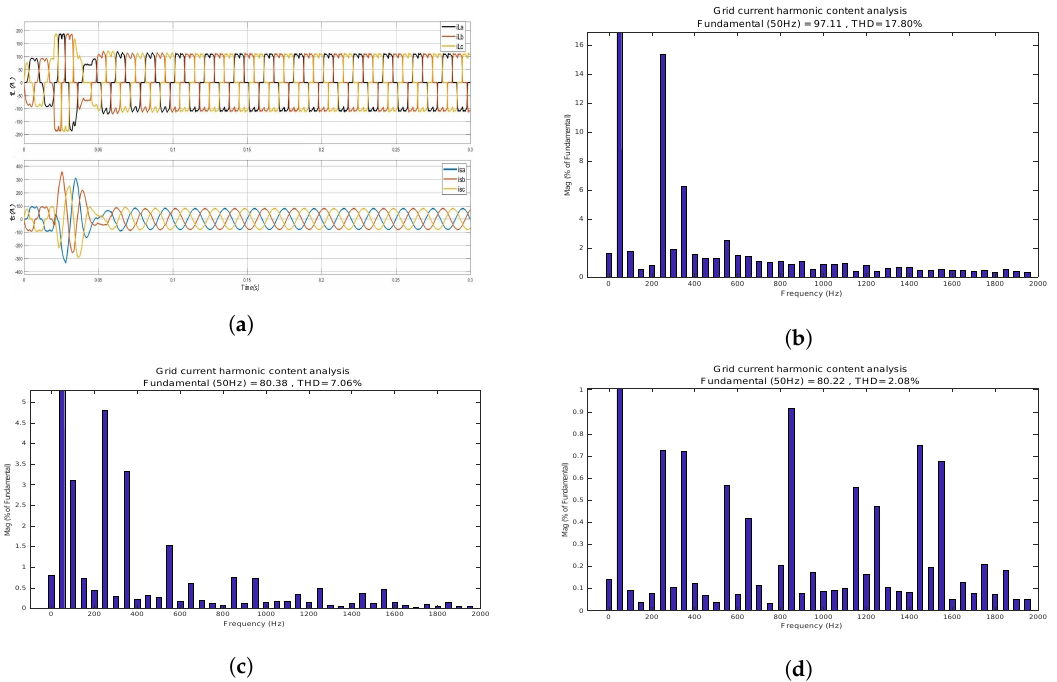
Figure 9. Scheme I: ( a ) nonlinear load current and grid current; ( b ) the FFT result of the nonlinear load current at the 0 s; ( c ) the FFT result of the grid current at the 0.07 s; ( d ) the FFT result of the grid current at the 0.15